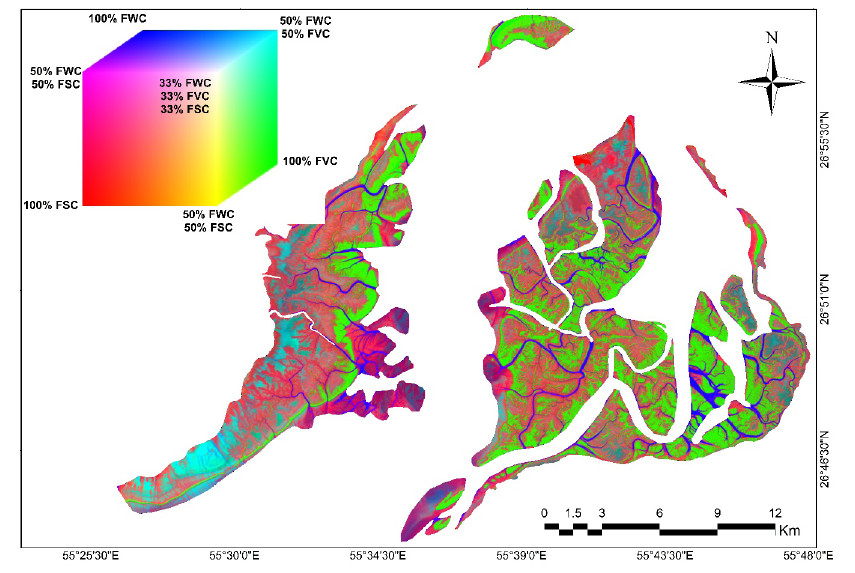
Figure 10. RGB color image from three covers in the entire region with RGB cube as a